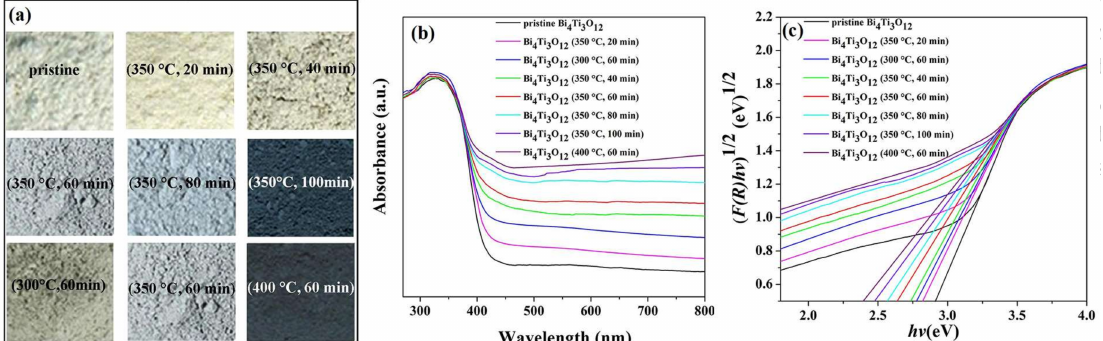
Figure 2. ( a ) photographs of pristine Bi 4 Ti 3 O 12 and various colored Bi 4 Ti 3 O 12 − x ; ( b ) UV-Vis absorption spectrum of the pristine Bi 4 Ti 3 O 12 and various Bi 4 Ti 3 O 12 − x ; ( c ) plot of the transformed Kubelka-Munk function (F( R ∞ )) versus the photon energy (h v ) for various Bi 4 Ti 3 O 12 − x and the pristine Bi 4 Ti 3 O 12